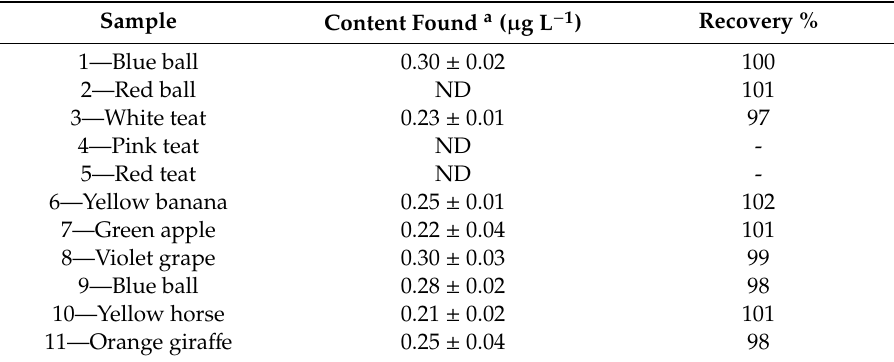
Table 3. BPA determined from toy and pacifier